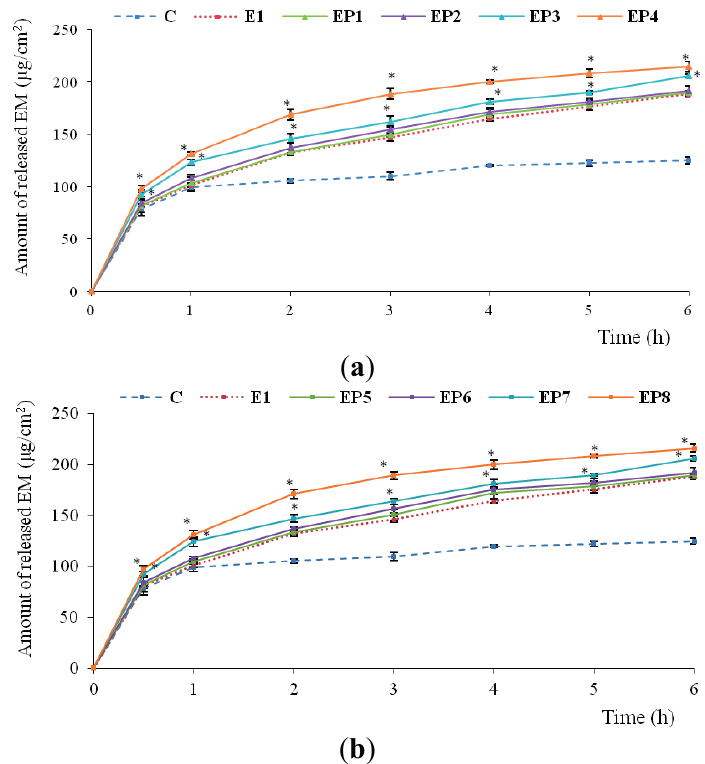
Figure 3. In vitro release of EM from hydrogels with different concentrations of ( a ) PAMAM-NH 2 G2 or ( b ) PAMAM-NH 2 G3 comparing with hydrogel without dendrimers (E1) and commercially available product (C). * p <